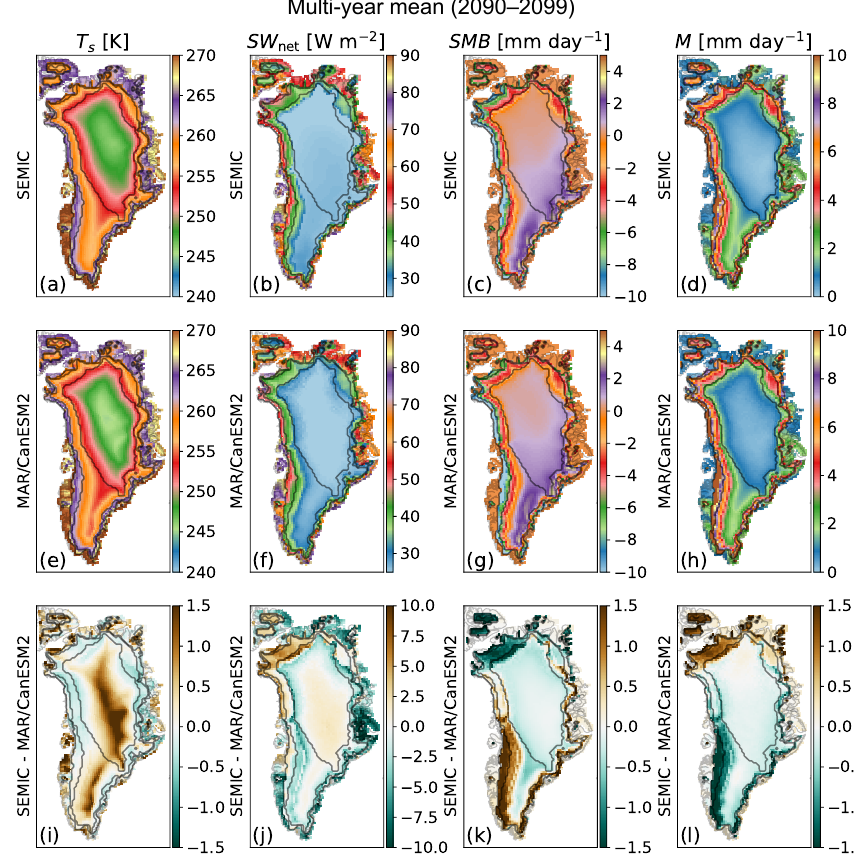
Figure 4. Comparison of multi-year (2090–2099) mean surface temperature T s , net shortwave radiation SW net , surface mass balance SMB, and surface melt M as modelled by SEMIC (a–d) and MAR (e–h) and the differences between SEMIC and MAR (i–l) . The outlined contours show the boundaries of the three ice-covered MAR regions as shown in Fig. 2. See Table 4 for values of minimum and maximum